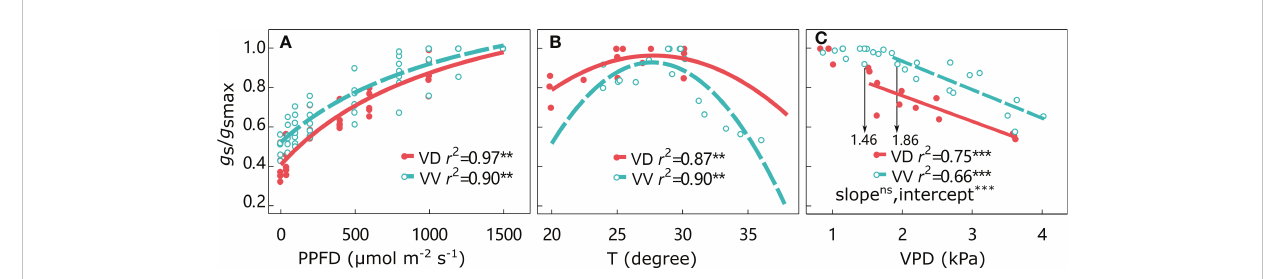
FIGURE 3 Relative stomatal conductance g s / g smax responses to photosynthetically active radiation (PPFD) (A) , temperature (T) (B) , and water vapor pressure de fi cit (VPD) (C) for ‘ Gala ’ apple trees grafted on vigorous rootstocks and associated with either a dwarf M26 interstock (VD) or a vigorous ‘ Qinguan ’ interstock (VV) for the whole tree. The threshold VPD values ensuring g s = g smax are presented. Regression coef fi cients (r 2 ) for all fi tted lines, linear regression signi fi cance and interstock effect on a slope and intercept for VPD are shown when P < 0.01 with ** and P < 0.001 with ***.